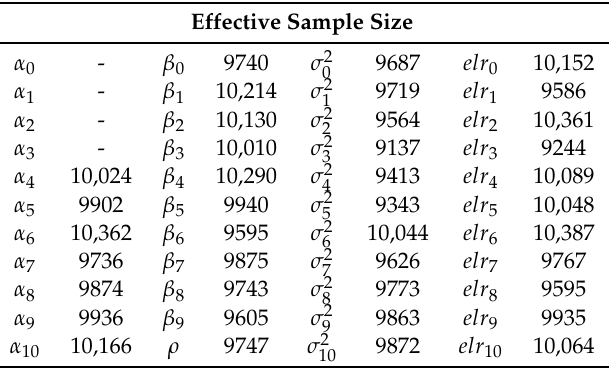
Table 3. The thin factor of 10 and the tight parameterization for the HMC procedure ensured the strong